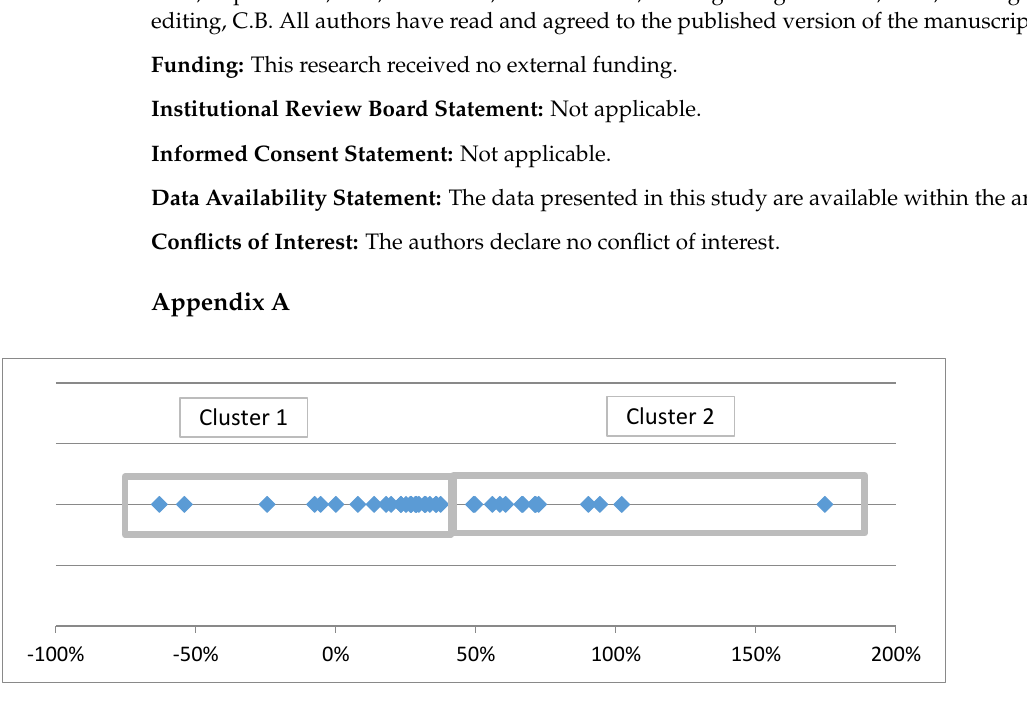
Figure A1. Percentage increase in actual prices paid 2016–2017 compared to 2015–2016.